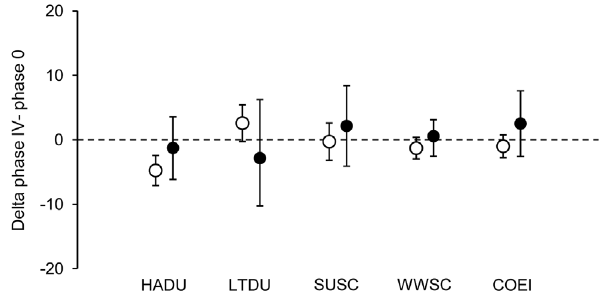
Figure 5. Intra-specific body mass variation for the studied species. Average deltas, representing the difference between body mass recorded at the phase IV of the moult in which seaducks are able to re-fly and initial body mass, and their respective confidence intervals. When the confidence intervals exclude the zero line, the delta is declared significant at 5% level (see Materials and methods).